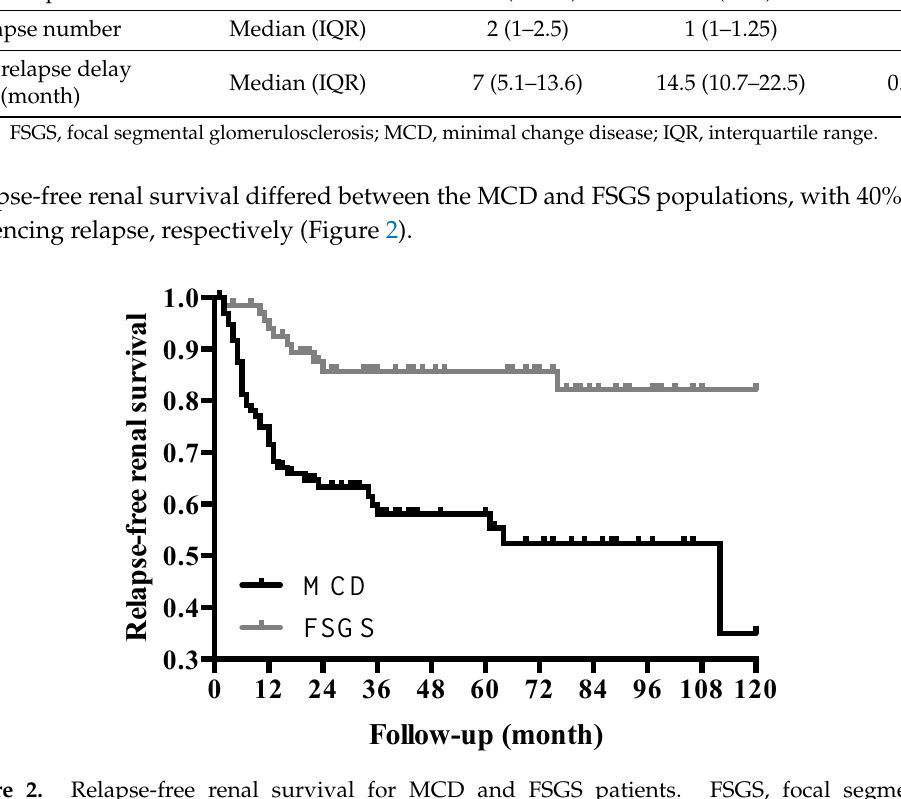
Figure 2. Relapse-free renal survival for MCD and FSGS patients. FSGS, focal segmental glomerulosclerosis; MCD, minimal change disease.